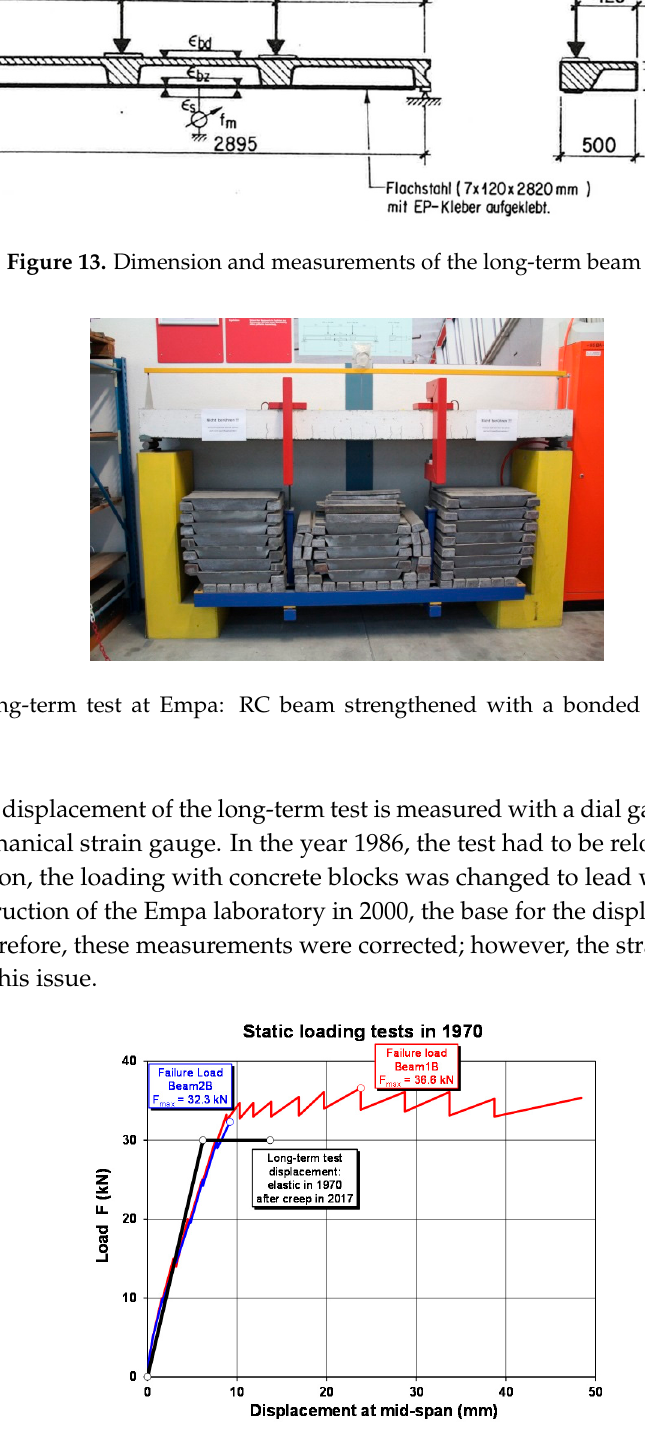
Figure 15. Load-displacement diagram of the static loading tests.